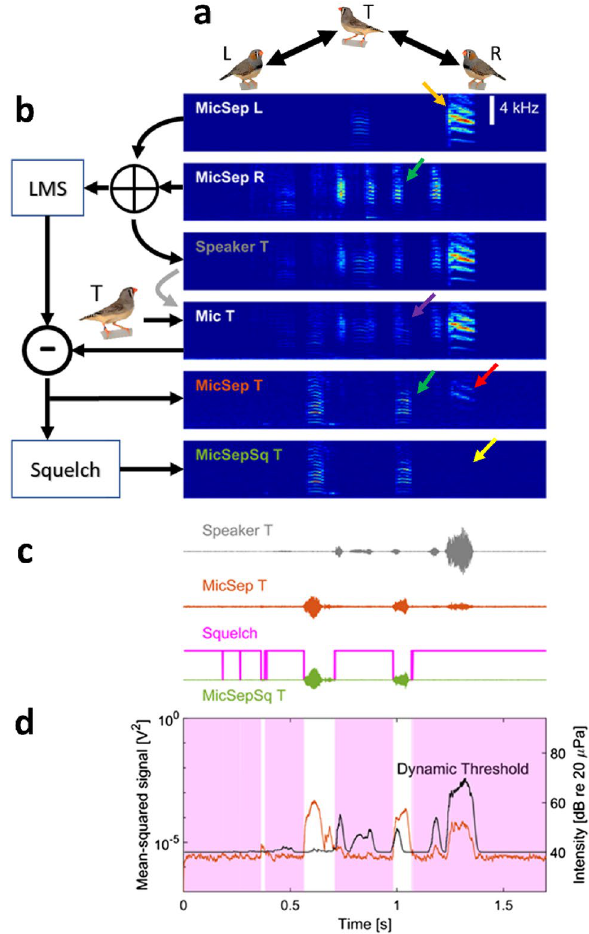
Figure 4. The dynamic squelch suppresses residual loudspeaker signals, demonstrated here for three birds connected in a hierarchical network. ( a ) The female T on top is bidirectionally connected (arrows) with two males L and R that are not supposed to hear each other (hierarchical network). ( b – d ) Example in which T and L call simultaneously (green arrows). ( b ) Even though Mic T records a superposition of both calls (magenta arrow), L’s call gets cleanly filtered out (MicSep T) by the LMS filter. In contrast, a louder call by L (orange arrow) leaves a significant echo on MicSep T (red arrow). The squelch removes the residual of that call on MicSepSq T (yellow arrow), which constitutes a clean signal, just as if L had been silent. Spectrograms have been normalized to individual color scales. ( c , d ) The squelch (magenta) is high when the mean-squared MicSep signal ( d , red) falls below the dynamic threshold ( d , black) composed of a fixed component and a dynamic component proportional to the mean-squared speaker signal. Shown are the Speaker T (gray), MicSep T (red), and MicSepSq T (green) sound waveforms. ( d ) The light magenta regions indicate times when the squelch is active and signal transmission is